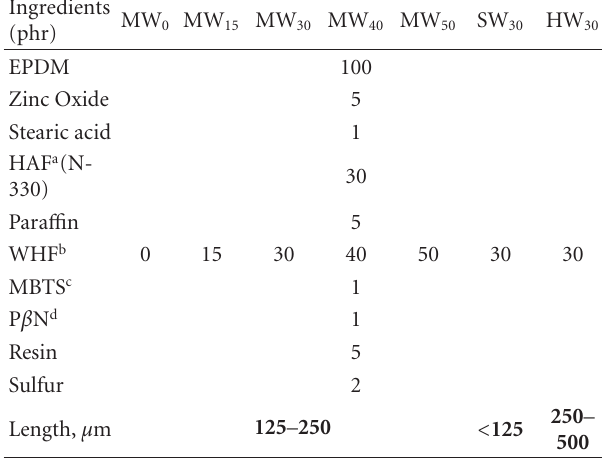
Table 2: Base formulation of WHFEPDM composites